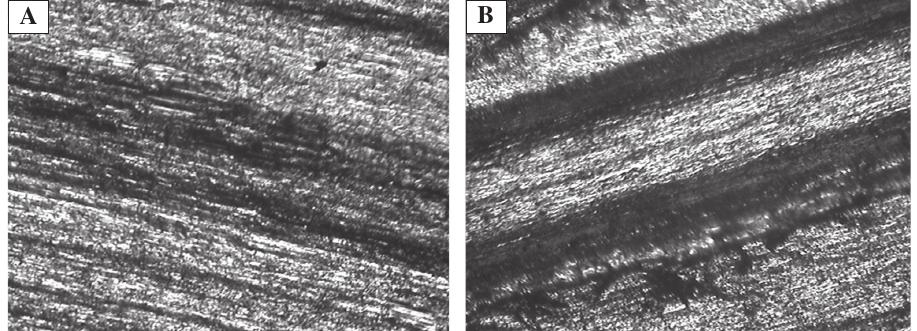
Figure 5 Worn-out surface of the composite with 5% SiCp at different loading conditions (50 × ).